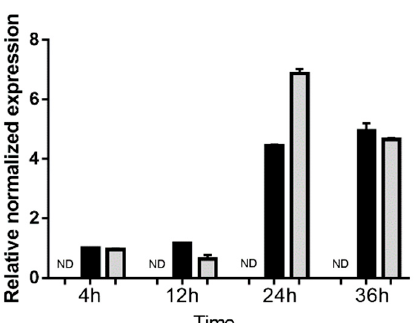
Figure 2. Expression of surface antigen 1 (SAG1) in human retinal Müller cells infected with T. gondii tachyzoites. Graph shows normalized SAG1 transcript expression in uninfected versus GT-1 and GPHT strain-infected MIO-M1 cells (multiplicity of infection = 5; evaluated time points post-infection = 4, 12, 24, and 36 h). Reference genes were ribosomal protein lateral stalk subunit P0 (RPLP0) and peptidylprolyl isomerase A (PPIA). n = 3 cultures / condition. Bars represent mean normalized expression, and error bars indicate standard deviation. Black columns represent GT1 strain-infected, and grey columns represent GPHT strain-infected.